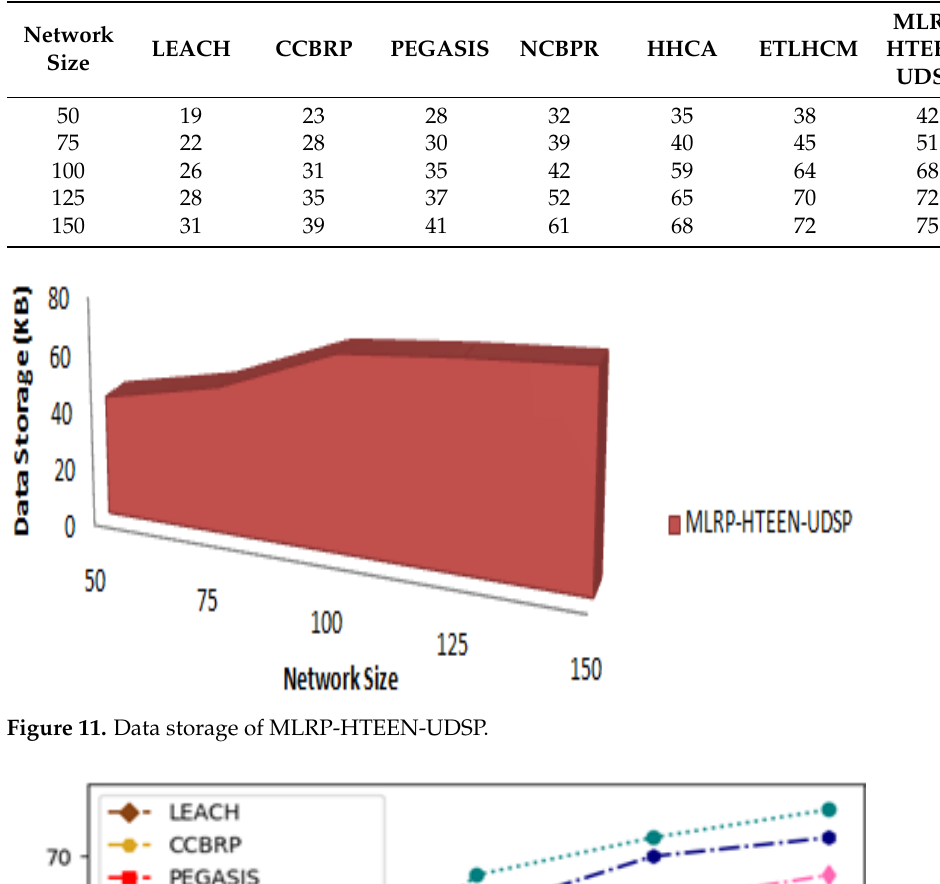
Table 6. Comparison of data storage.